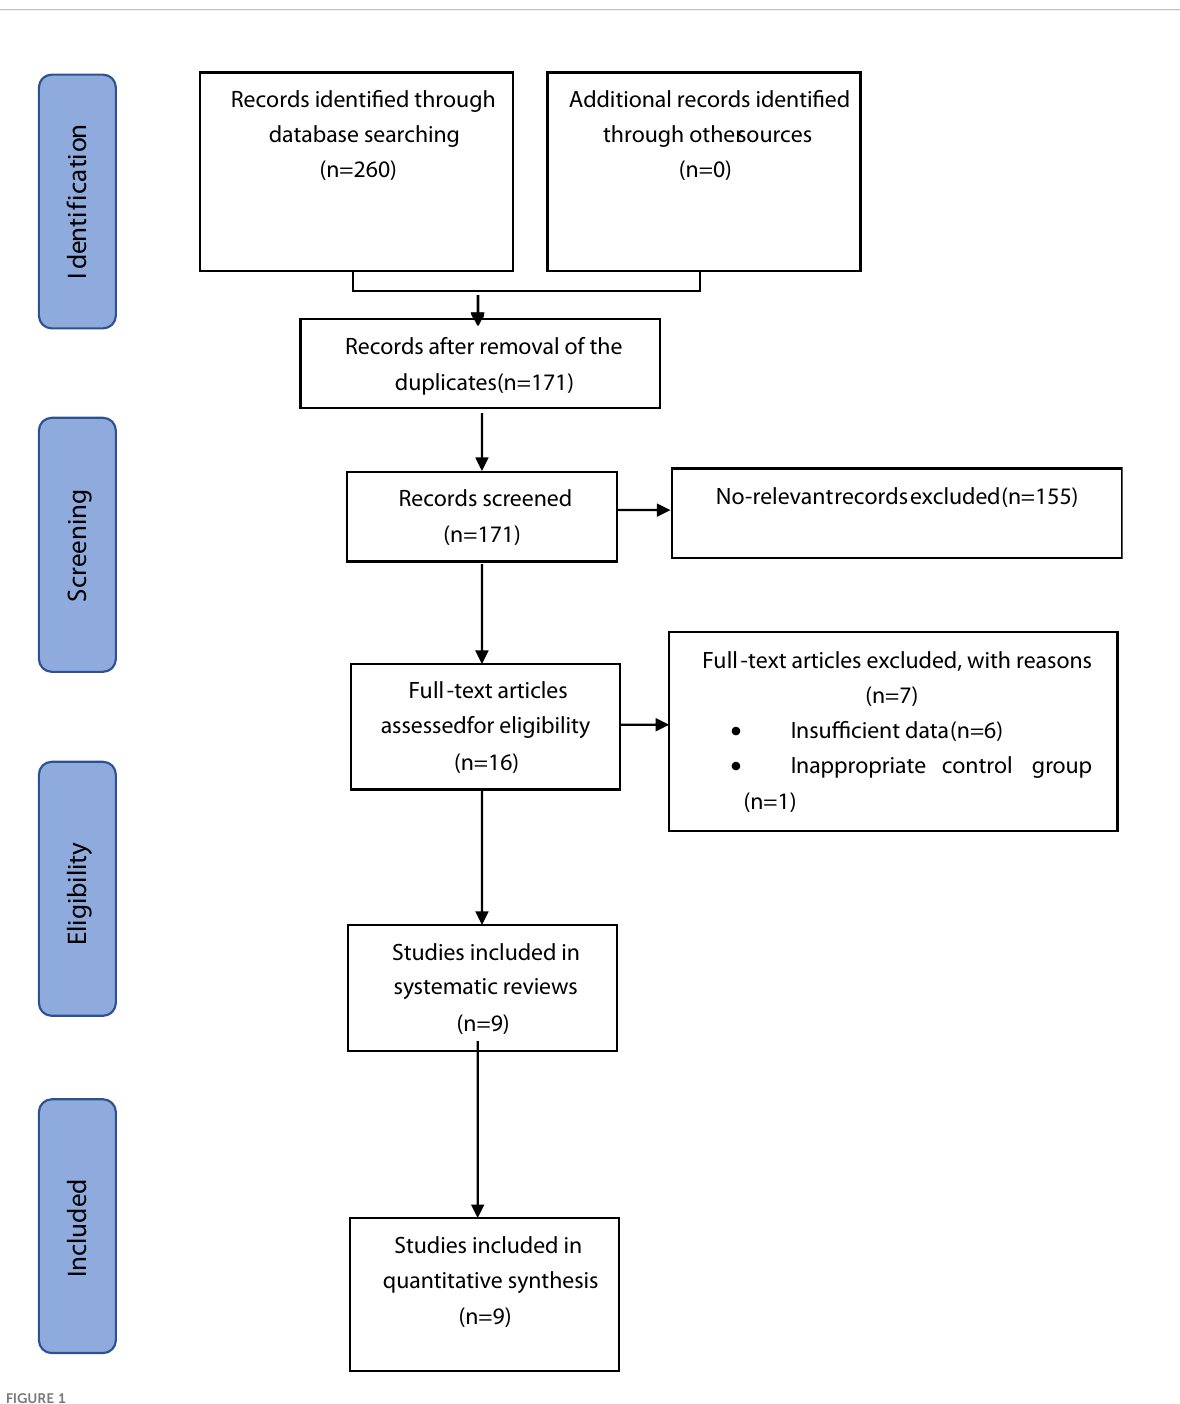
FIGURE 1 Flow chart of the study selection